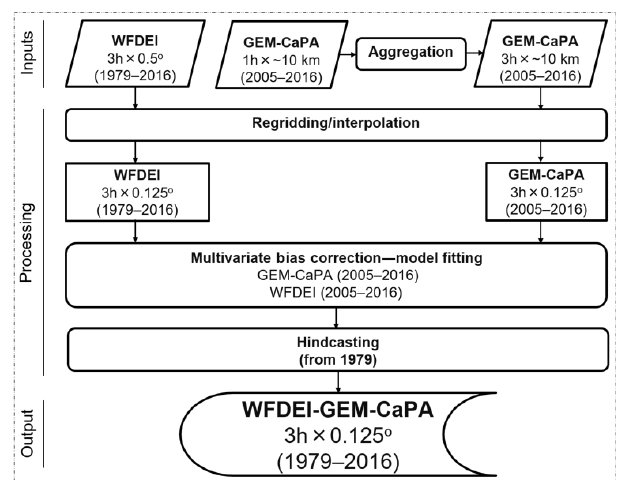
Figure 3. A schematic representation of inputs and the bias correc- tion procedure used to produce the WFDEI-GEM-CaPA meteoro- logical forcing